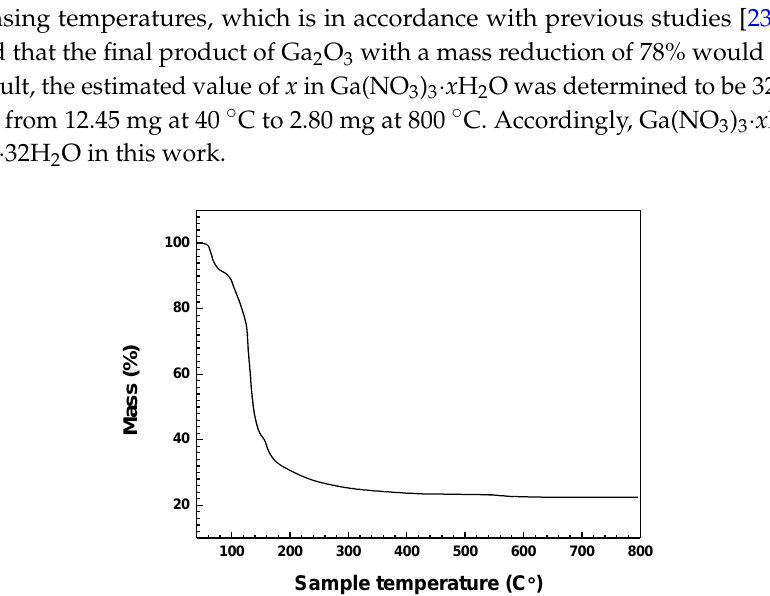
3 ) 3 ¨ x H 2 O raw